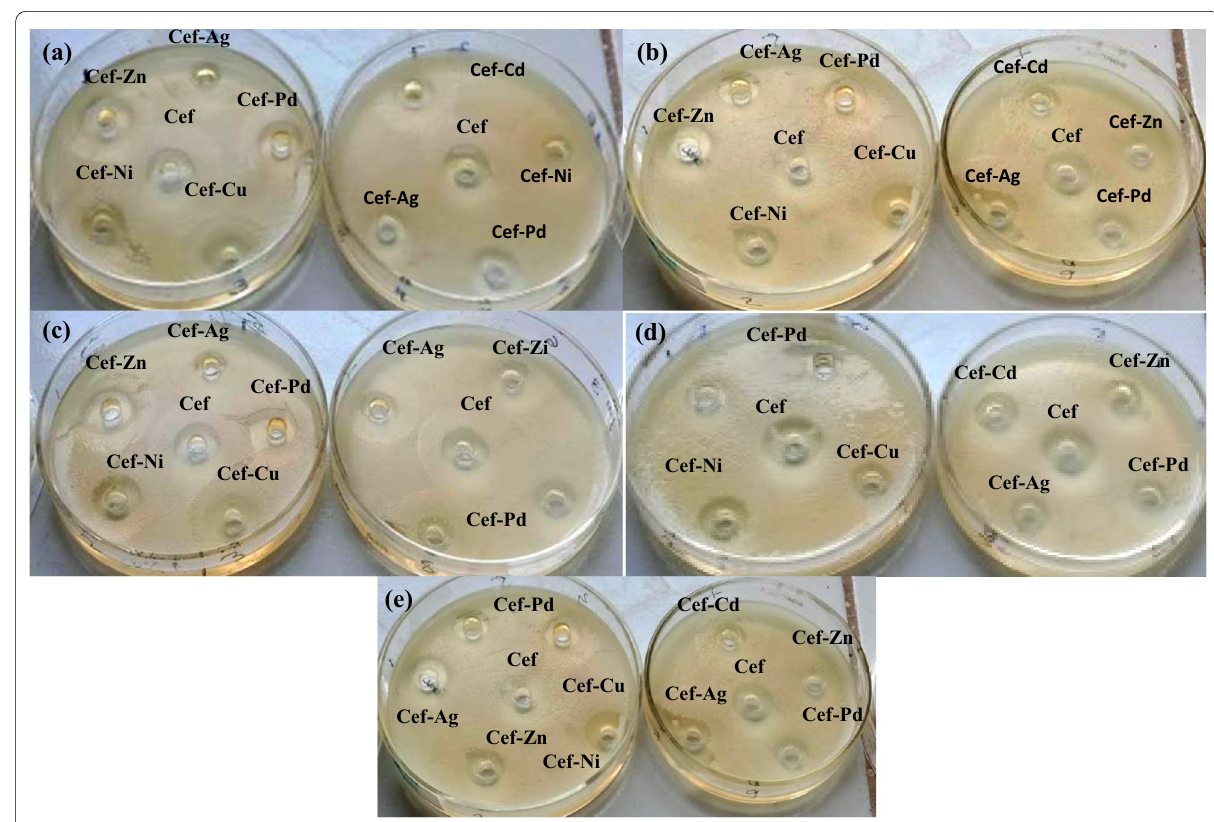
Fig. 7 Antibacterial activity by cefixime and its synthesized complexes a P. aeruginosa , b K. pneumonia , c E. coli , d B. subtilis and e S.